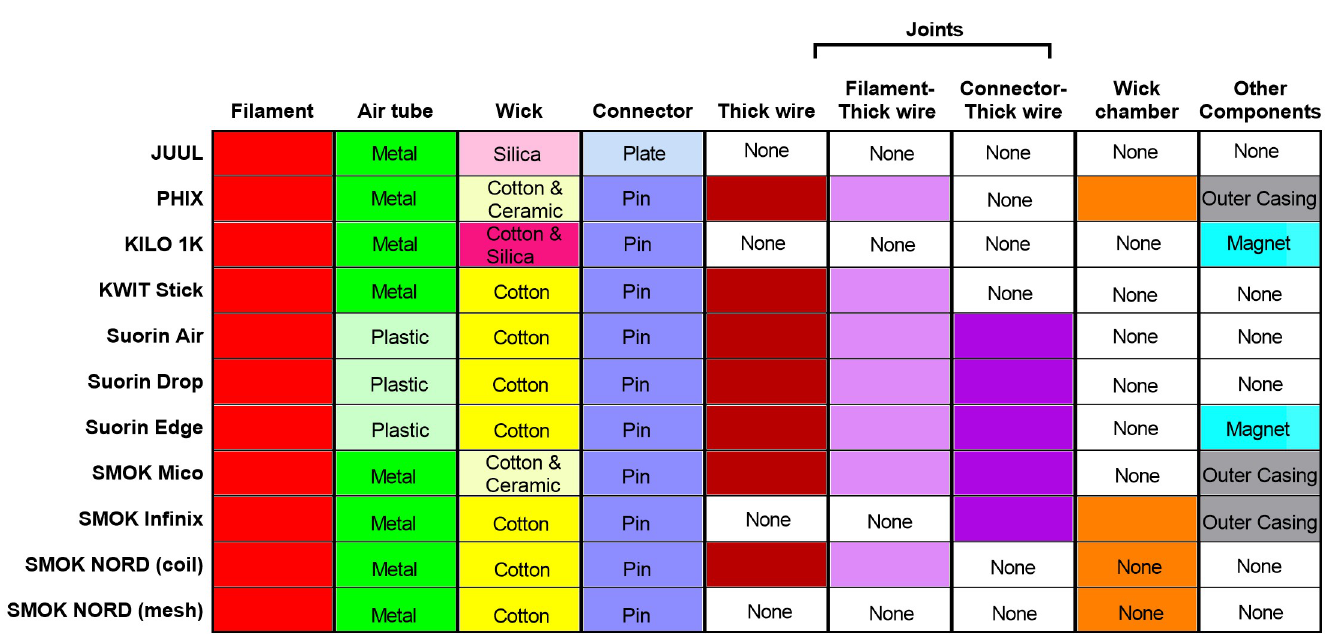
Fig 1. Atomizer components that were present in multiple brands of pod ECs. ECs are listed on the left axis, and pod components are listed above each